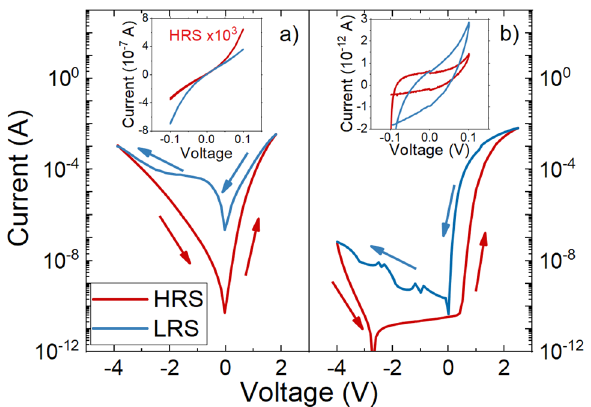
Figure 5. IV curves for samples with two different values of ( a ) (Sr/Ti) liq = 3.2, and ( b ) 3.6. The IV curves are measured in the range of − 4 V to + 3 V showing two different states of resistivity. The upwards measurement in HRS is shown as red line, while the downwards measurement is shown as blue line. The probing of the state (HRS/LRS) is shown in each plot as inset.